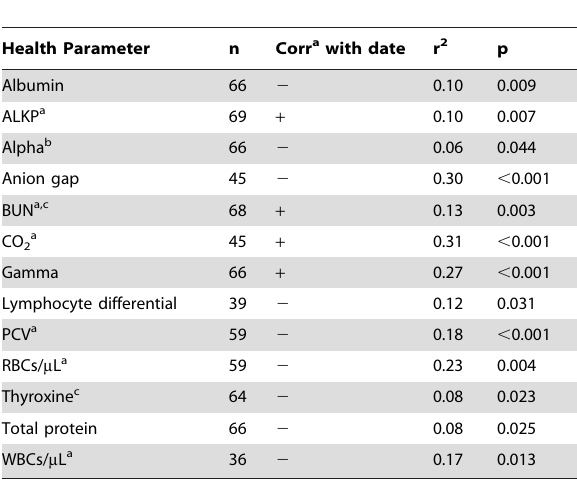
a ALKP=Alkaline phosphatase, BUN=Blood urea nitrogen, CO dioxide, Corr=Correlation, PCV=Packed cell volume, RBC=Red blood cell, WBC=White blood cell. b Log transformed.